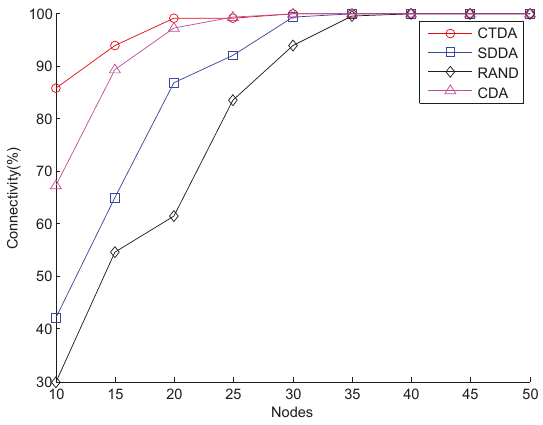
Figure 7. Connectivity with varying numbers of